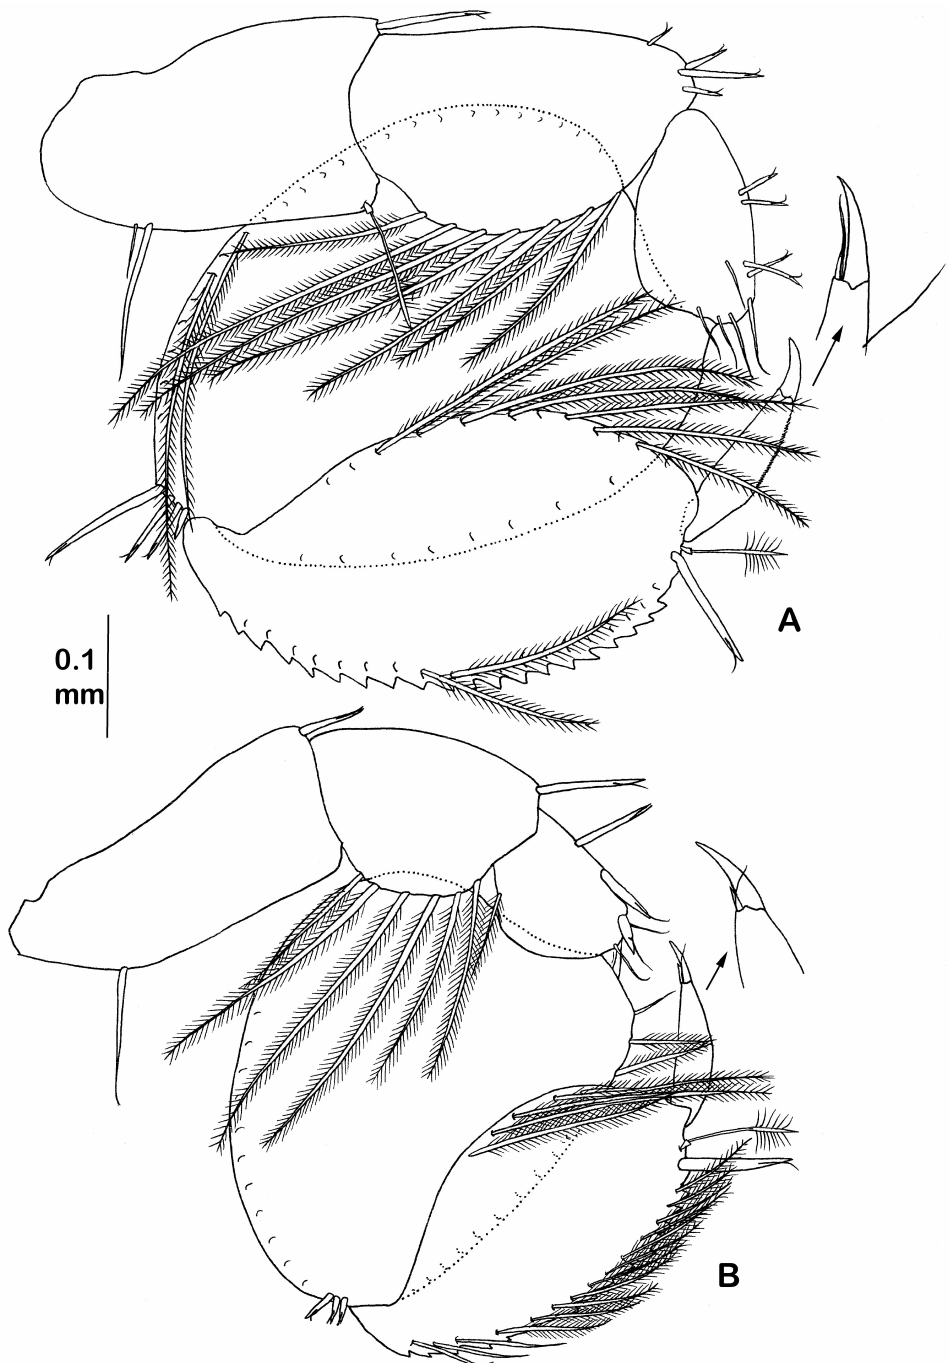
Figure 29. Eurycope emmae sp. nov. Male holotype (ZMH K-45652): ( A ) pereopod V; ( B ) pereopod